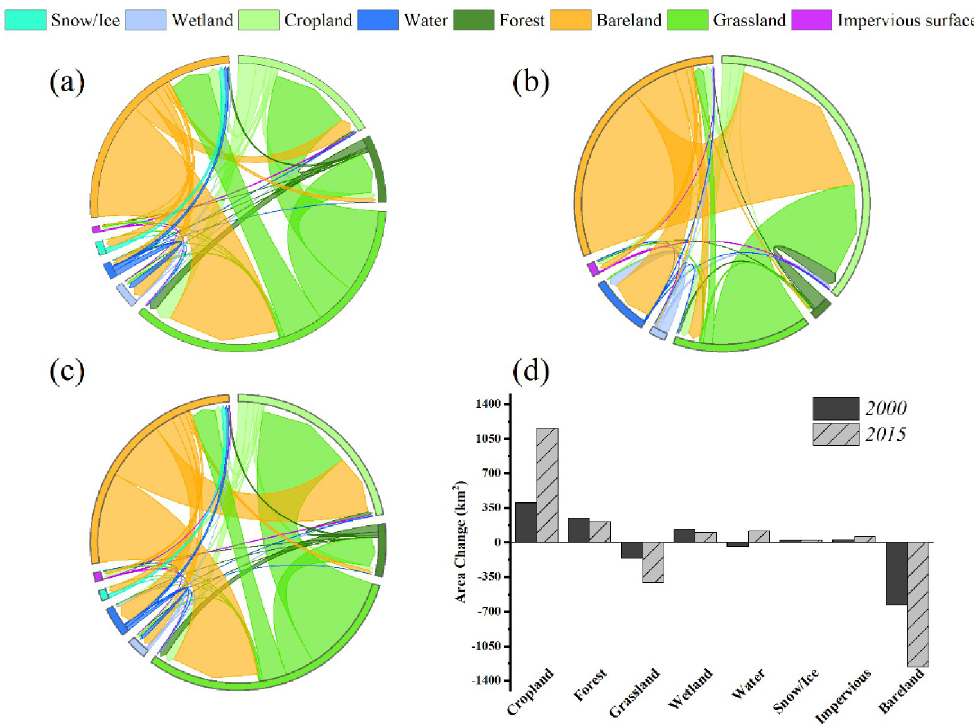
Fig 8. Land cover type changes from 1980–2015: (a) area shift in land cover types from 1980 to 2000; (b) area shift in land cover types from 2000–2015; (c) area shift in land use from 1980–2015; (d) changes in the area of 8 land cover types in 2000 and 2015 relative to